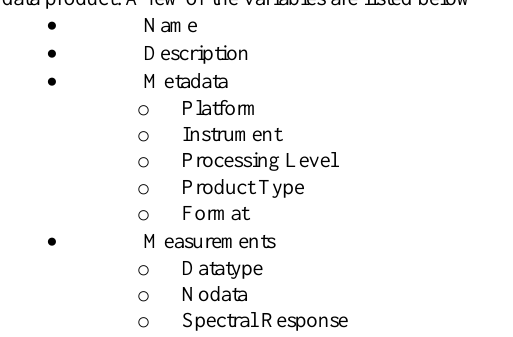
Figure 3. Database